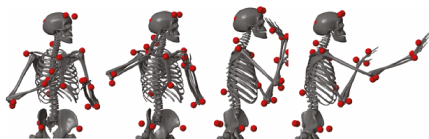
Figure 1: Overhead throwing motion. Example of an overhead throwing motion to a 4 m target (bone graphics issued from [27]). Representative posture of each phase of the motion is shown.